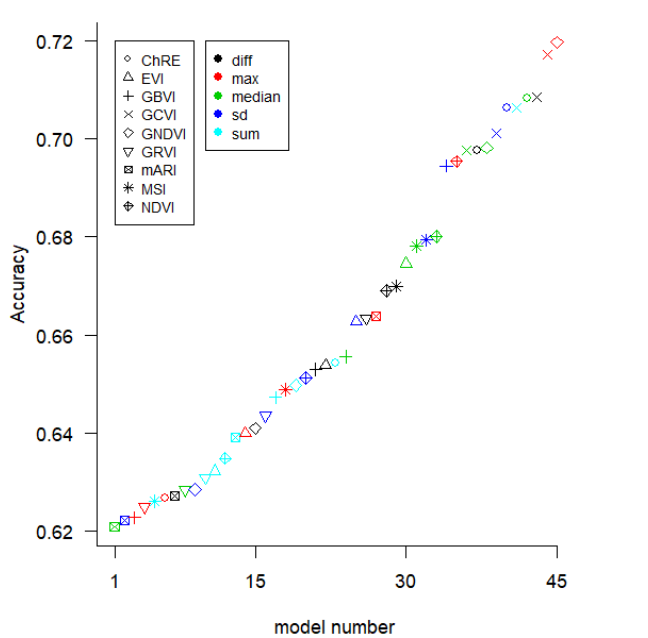
Figure A2. Accuracy for full-field, single-variable linear regression models by predictor variable, where the colors represent the aggregation type of the vegetation index (the sum, median, standard deviation = sd, maximum=max, or difference between minimum and maximum = diff) for each vegetation index.